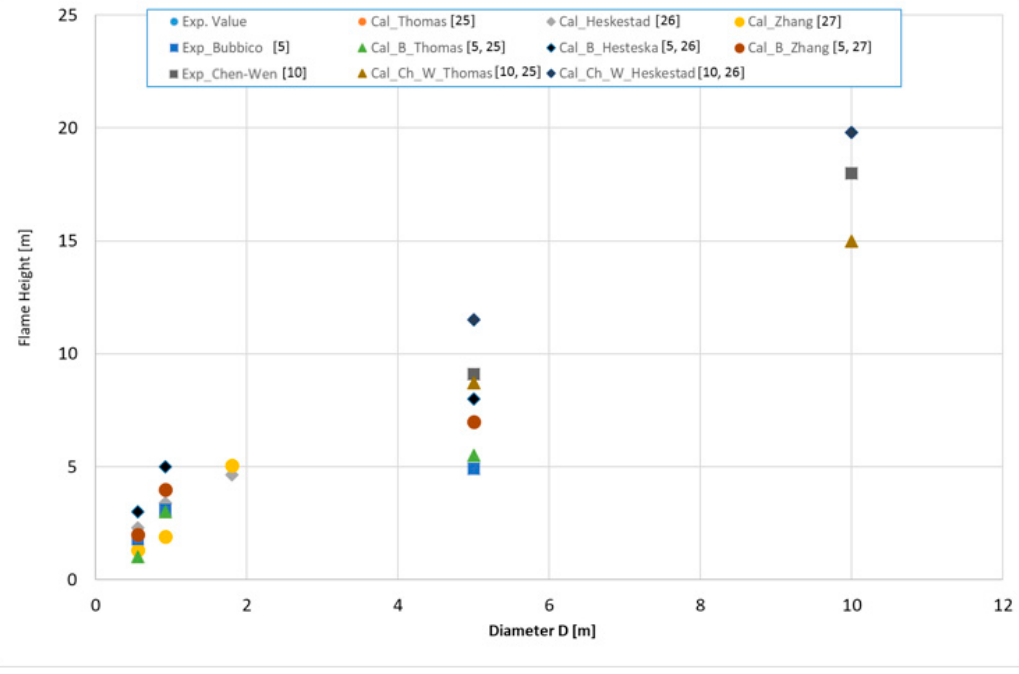
Figure 6. Flame height for gasoline. Experimental data and calculated predictions. Legends: Exp.—presents experimental values, Cal presents calculated values by actual author.